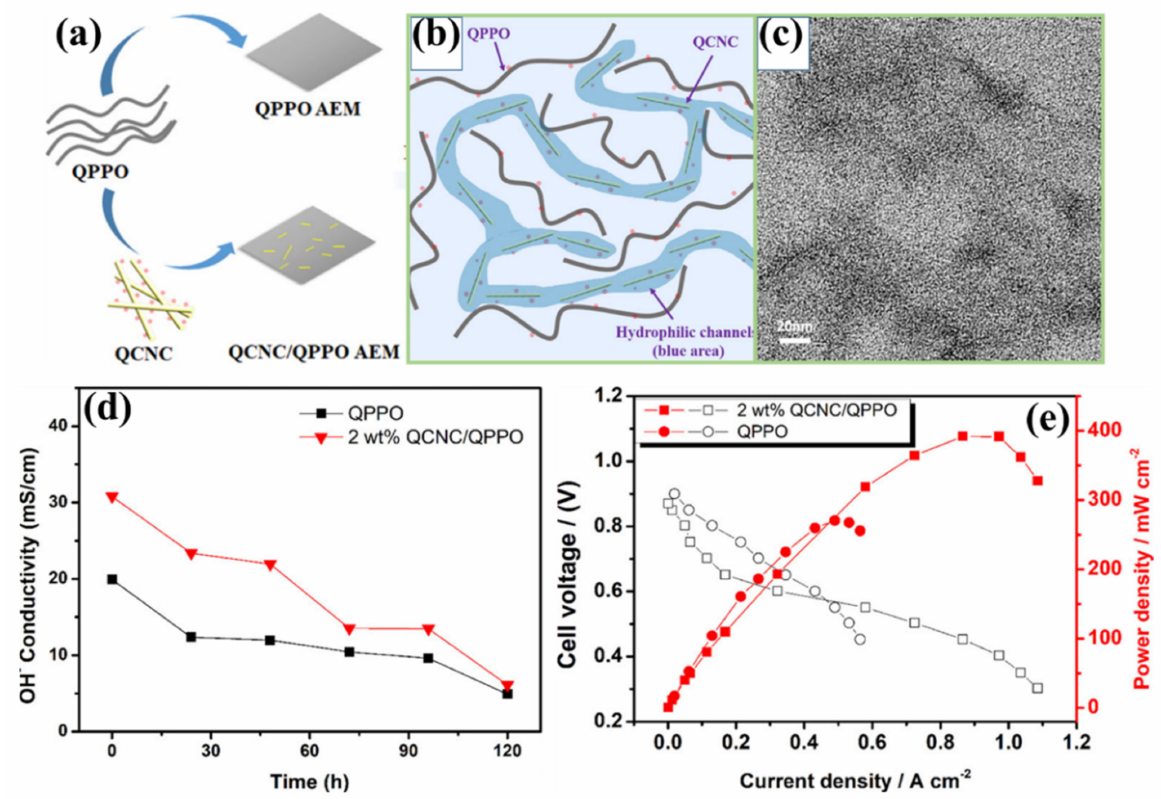
Figure 11. ( a ) Schematic diagram of QCNC–QPPO membrane, ( a ) preparation process, and ( b ) hy- drophilic channels in the matrix. ( c ) TEM images of QCNC–QPPO membrane. ( d ) Alkaline stability and ( e ) H 2 /O 2 fuel cell performance of pure QPPO and QCNC–QPPO membranes. Reprinted with permission from Ref. [175]. Copyright © 2018, American Chemical